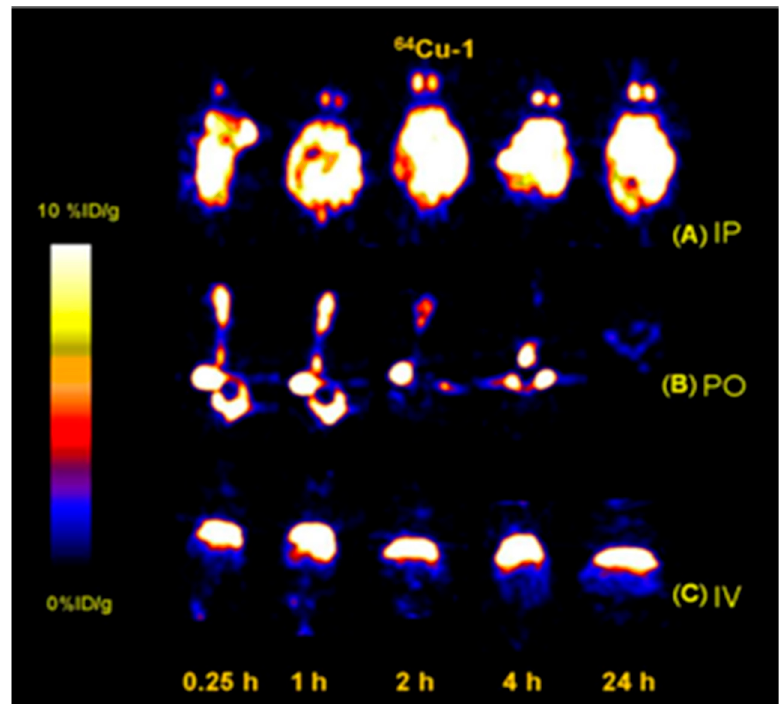
Figure 12. Coronal PET images of the antimicrobial peptoid 64 Cu-1 after ( A ) intra-peritoneal (IP), ( B ) oral (PO), and ( C ) intravenous (IV) administration in Balb/C mice at different time points (n = 4). Reprinted with permission from Seo et al. (2012) [129]. Table 3. Summary of PET radionuclides and reaction parameters used in the preparation of radio- labeled peptides for pre-clinical and clinical imaging [105,114,116,117,134–136]. a N-succinimidyl 4-[ 18 F]fluorobenzoate; b 4-[ 18 F]fluorobenzaldehyde; c 2-[ 18 F]fluoro-2-deoxyglucose; d diethylenetri- aminepentaacetic acid; e 1,4,7-triazacyclononane-1,4,7-triacetic acid; f